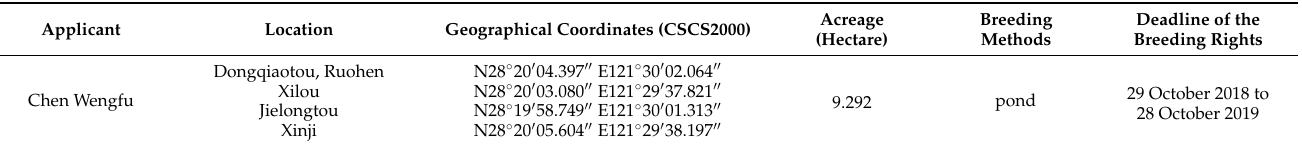
Table 2. Registration table of a water area (source: http://www.wl.gov.cn/art/2018/10/19/art_1402221_22027457.html, accessed on 26 October 2021).